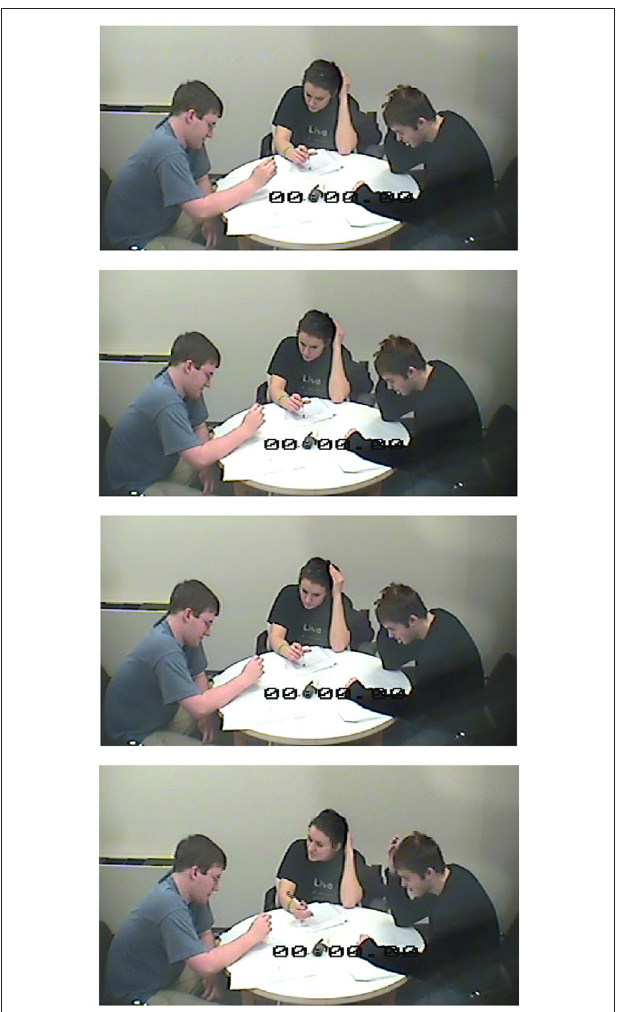
FIGURE 3 | Four-second sequence of screen grabs of self-managing team demonstrating more self- than other-focused attentional